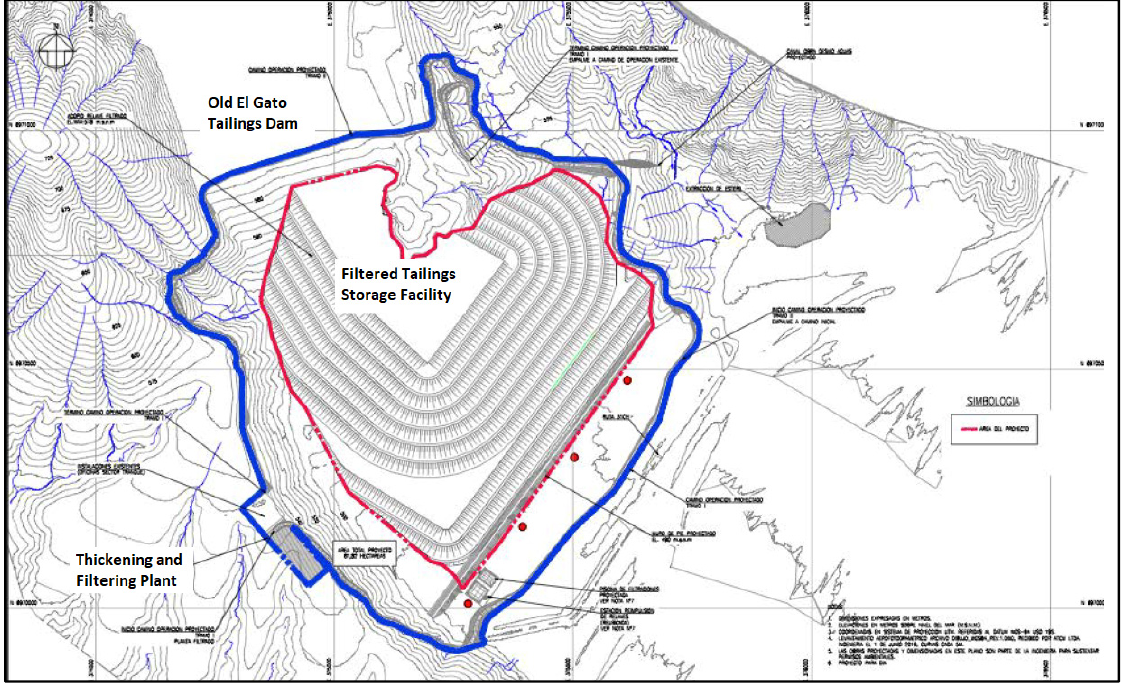
Figure 26. El Gato Creek Filtered Tailings Storage Facility—Layout [27,47,61]. The filtered tailings deposit system corresponds to a mechanized method, consisting of transport from the temporary storage area to the filtered tailings deposit, in 25-tonne hopper trucks, allowing the placement of the tailings in the storage areas using a bulldozer, forming layers of filtered tailings, compacted by 10-ton compacting rollers until reaching the maximum dry compacted density, equivalent to 95% of the Proctor Standard